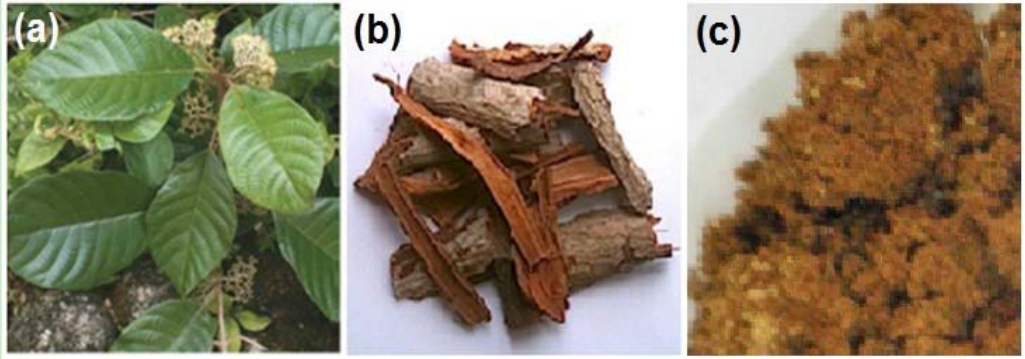
Figure 8. Callicarpa maingayi Plant ( a ); Stem bark of Callicarpa maingayi ( b ); Stem bark powder of Callicarpa maingayi ( c